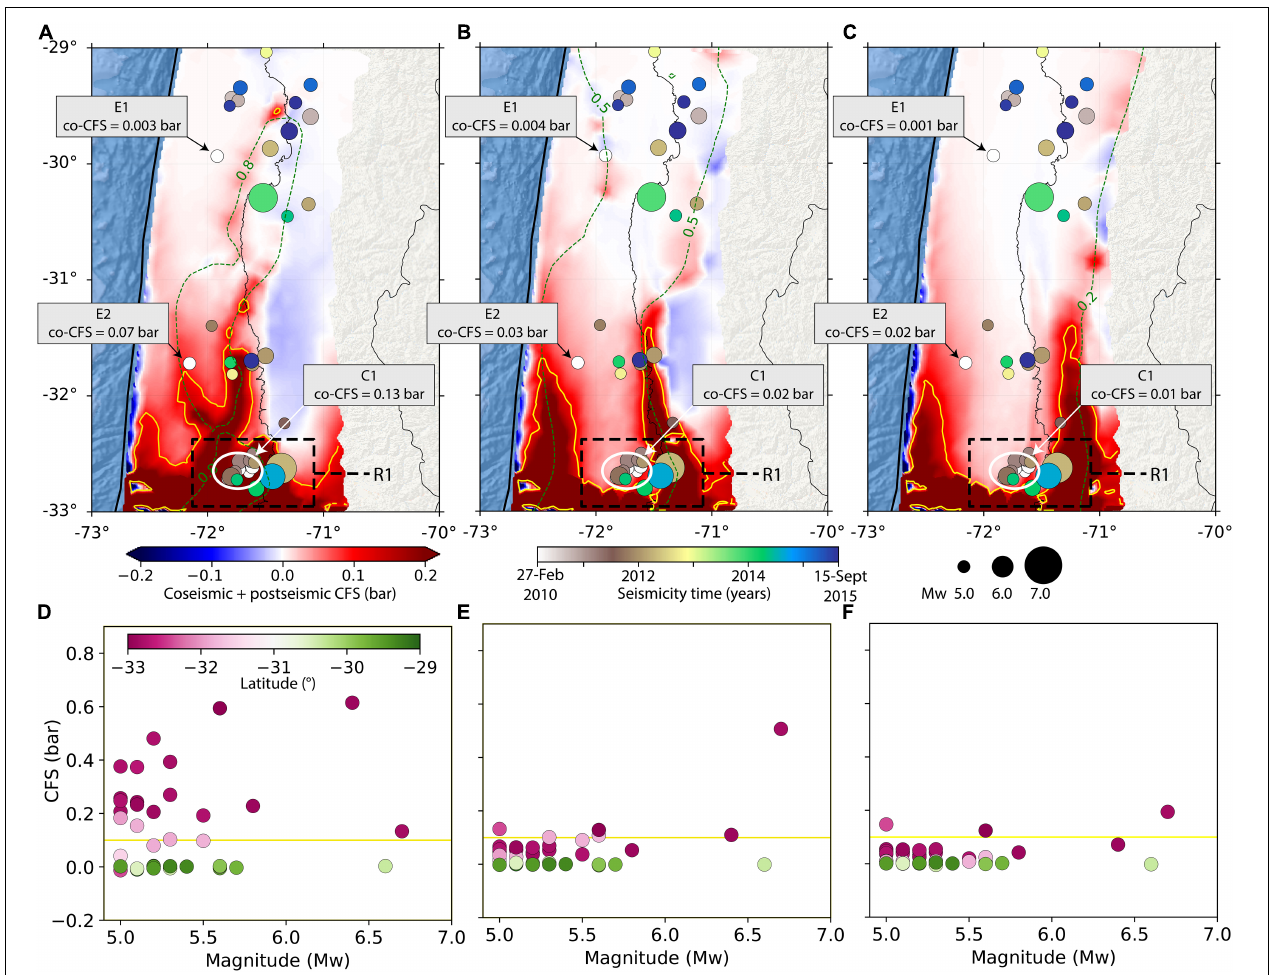
FIGURE 4 | Total CFS (coseismic plus postseismic) changes extracted from the power-law rheology model results and seismicity Mw ≥ 5.0 (USGS-NEIC catalog) in the Illapel segment between the 2010 and 2015 events associated for scenarios I (A) , II (B) , and III (C) . The receiver fault parameters are the same as Figure 3 . Upper panel exhibit the sum of the CFS as shown in Figures 3A,B,D.E,G,H . The solid-yellow contours depict zones of CFS changes ≥ 0.1 bar. (D–F) in the lower panel display the total CFS calculated at each seismicity hypocenter versus seismicity magnitude for scenarios in (A–C) , respectively. As in Figure 3 , the locking region ≥ 0.2 in (C) is the one between the dashed-green line and the trench (solid-black